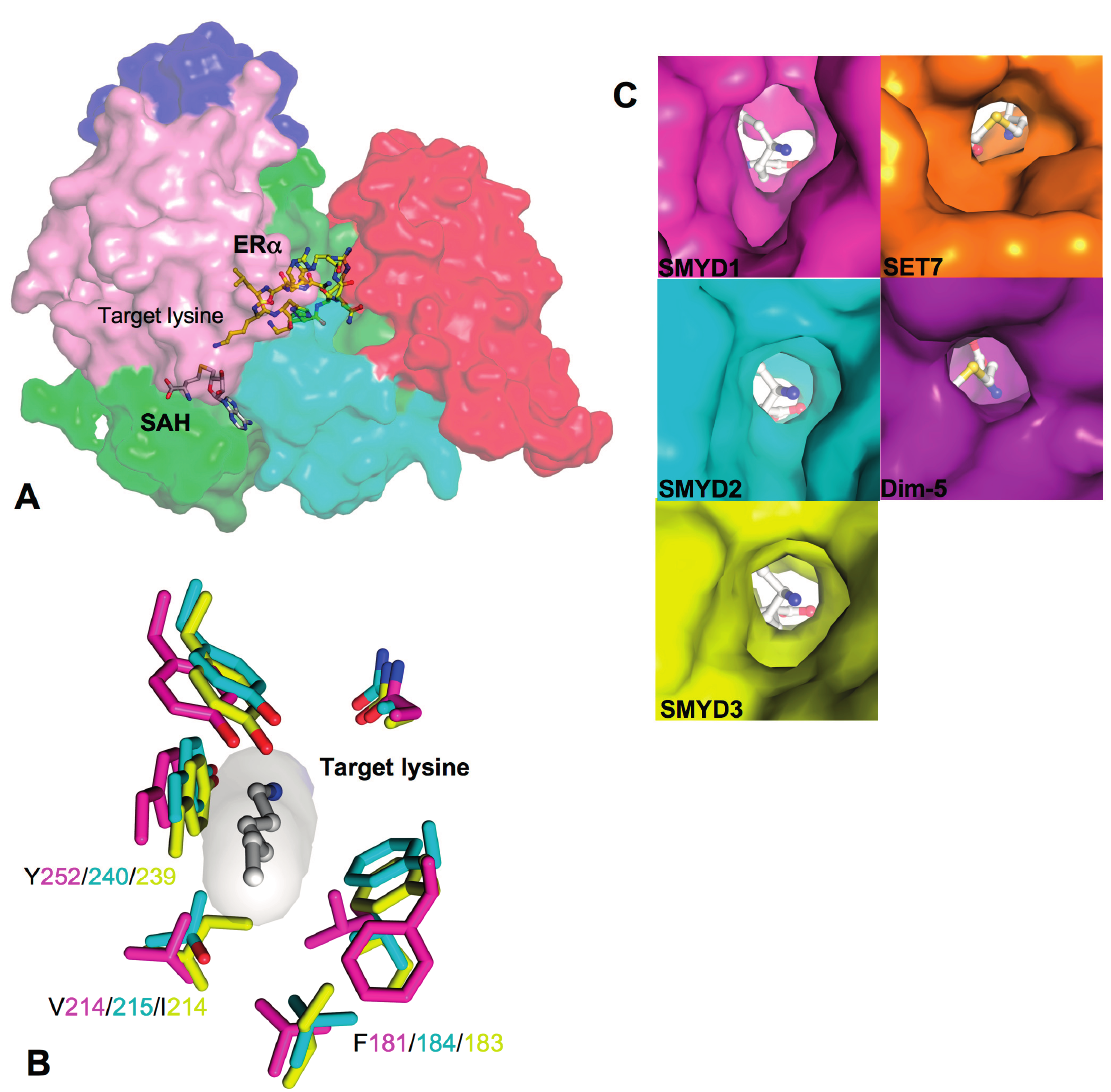
Figure 5. Target lysine access channel. ( A ) Surface representation of overall SMYD2–ER α structure. ER α peptide, SAH, and target lysine are indicated; ( B ) Superposition of the lysine access channels. SMYD residues are represented by sticks with the carbon atoms colored according to the scheme in Figure 1C. Target lysine is colored in white; and ( C ) Surface representation of the lysine access channel of SMYD1–3, SET7, and Dim-5. SAH or SFG is depicted by sticks with the carbon atoms colored in